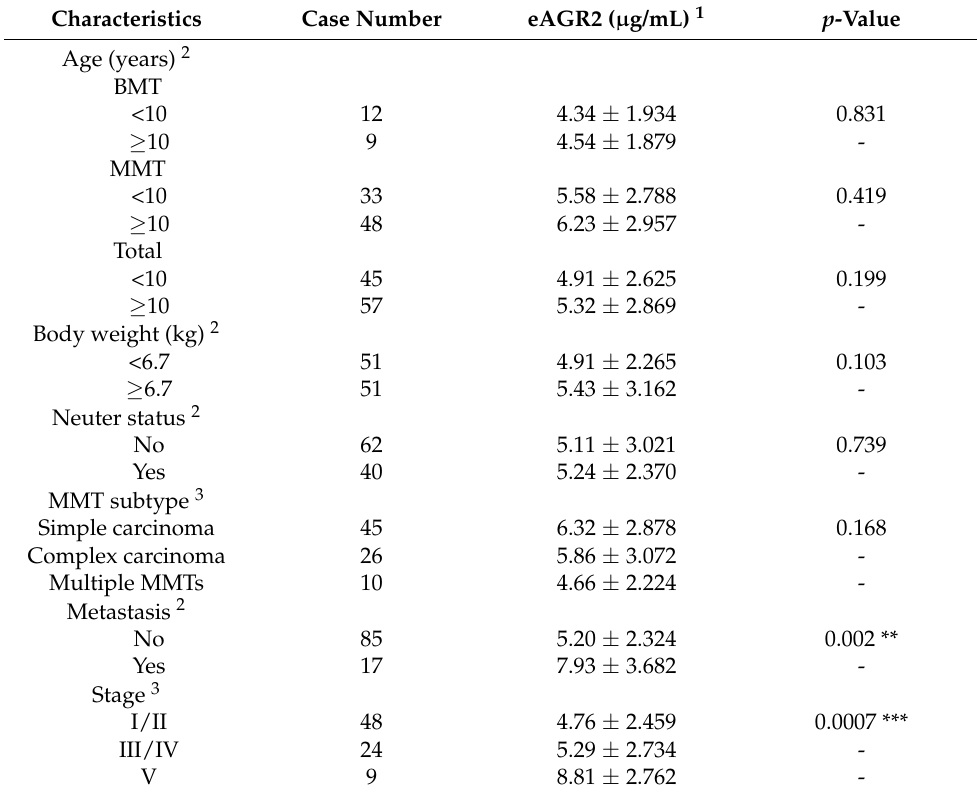
Table 2. Correlation between patient signalment and serum eAGR2